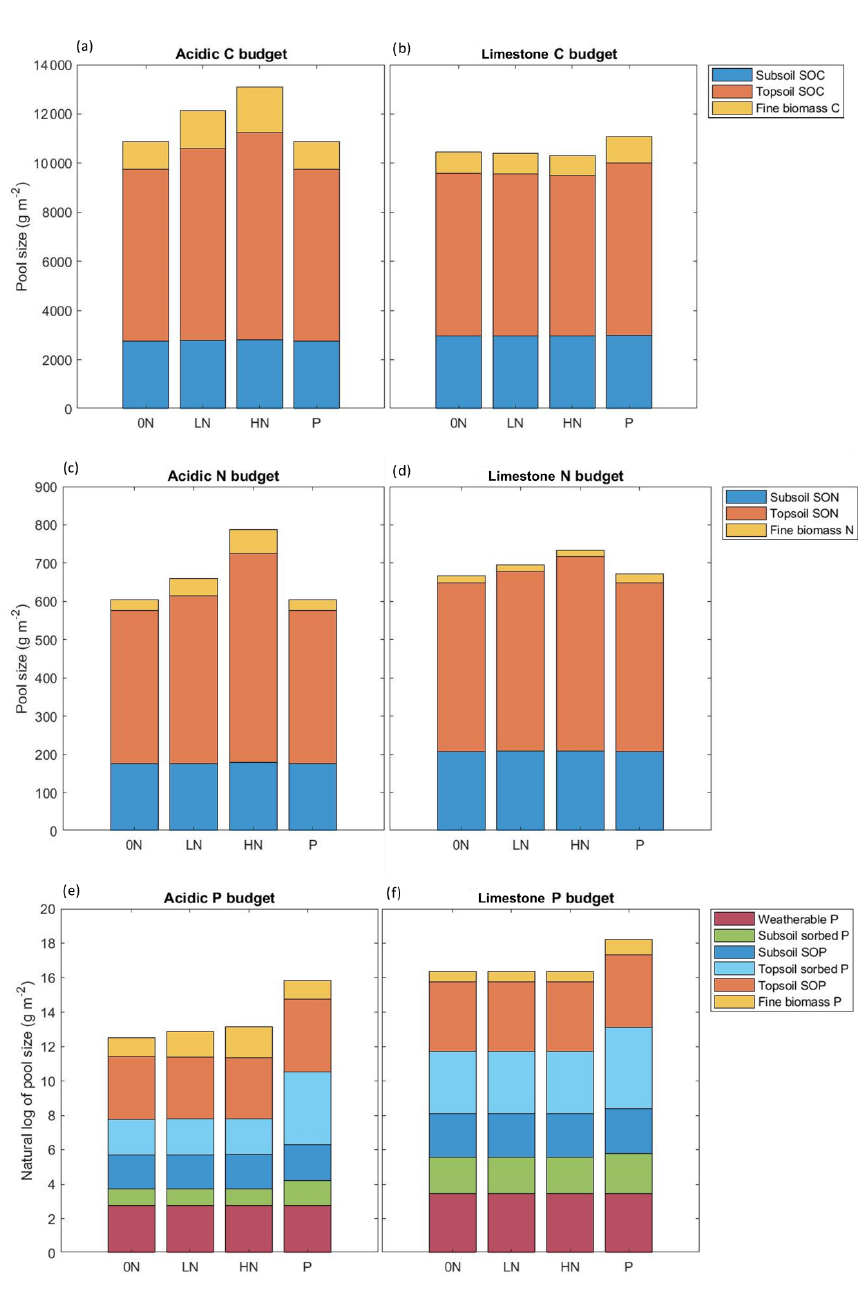
Figure 5. Modelled C, N, and P budgets for the acidic (panels a , c , and e ) and limestone (panels b , d , f ) grasslands for the year 2020. Modelled sizes of C and N pools are in grams per metre squared, and P pools are presented as the natural log of grams per metre squared. Temporary pools such as available N and P and fixed N are not presented here to avoid “double counting” in other pools, and wood litter C, N, and P are not presented due to their negligible